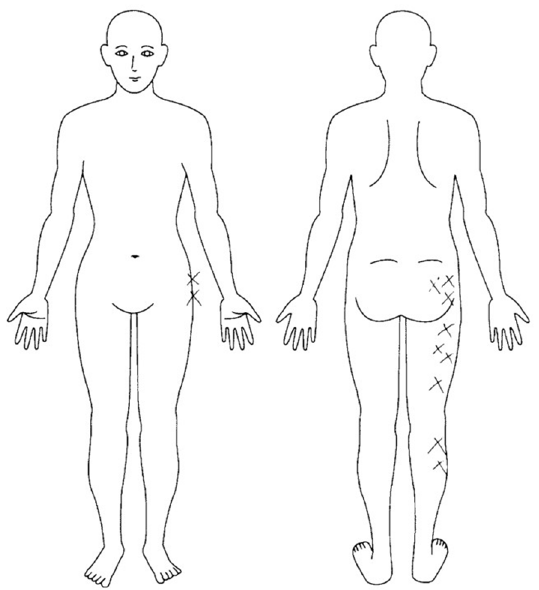
Figure 2. Region of numbness.